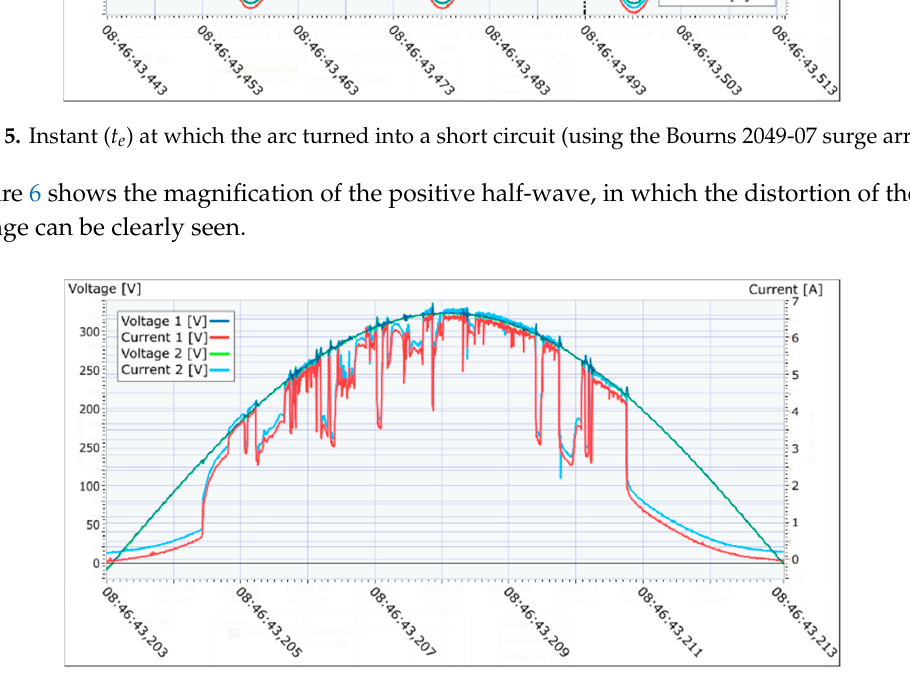
Figure 6. Deformation of the arc (using the Bourns 2049-07 surge arrester).